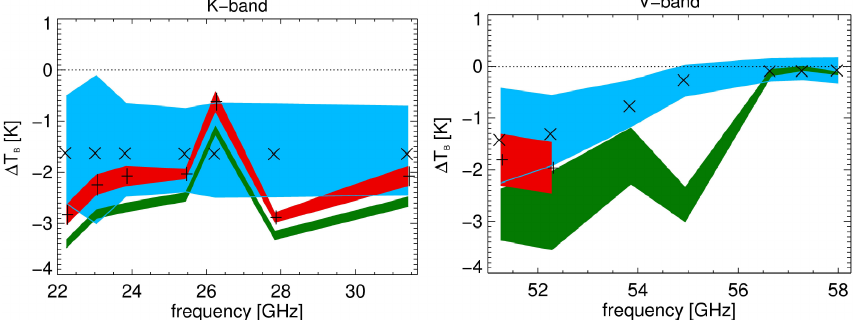
Fig. 11. Calibration comparison for HATPRO channels (left panel: K-band, right panel: V-band): 1T b refers to the mean zenith T b values based on the original LN 2 calibration on 11 August 2009 (boiling point correction Eq. 12). X: LN 2 calibration results with the improved boiling point correction (Eq. 15), light blue: estimated uncertainty range of the LN 2 calibration (Table 5), + : tipping curve results, red: esti- mated uncertainty range associated with the tipping curve calibration (Table 5), green: range of zenith T b differences from radiative transfer calculations with three different absorption models: Liebe’87 (Liebe, 1987), Liebe’93 (Liebe et al., 1993) and Rosenkranz’98 (Rosenkranz, 1998). V-band calculations for < 56GHz have been convolved with the real band-pass filter shapes measured with a resolution of